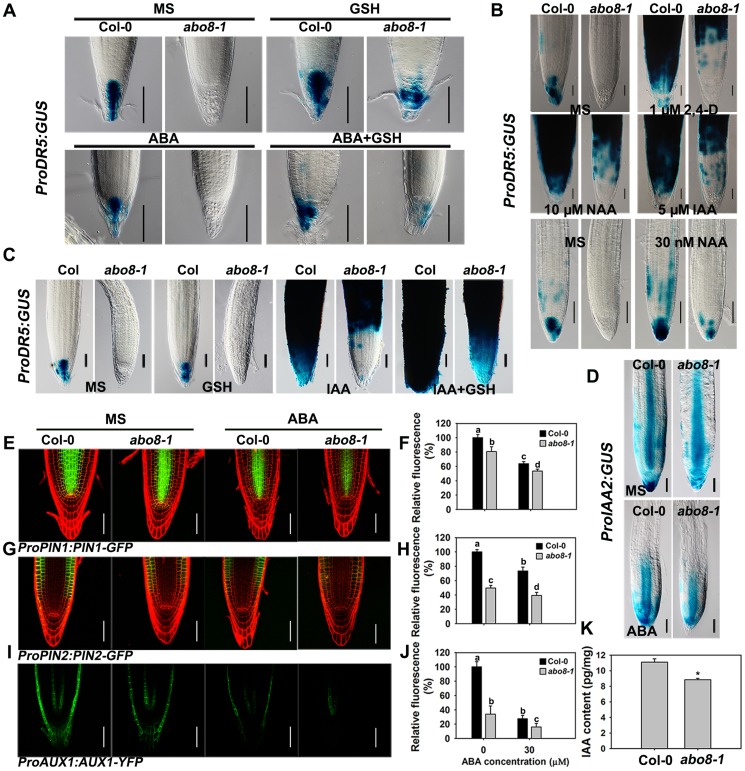
Expression of DR5, IAA2, PIN1, PIN2, and AUX1 is altered in the abo8-1 mutant.A. The expression of ProDR5:GUS in roots of seedlings grown on MS medium or MS medium containing 30 µM ABA, 300 µM GSH, or 30 µM ABA plus 300 µM GSH for 5 days. Bars = 50 µm. B. The expression of ProDR5:GUS in 5-day old seedlings treated in liquid MS medium without or with 1 µM 2,4-D, 5 µM IAA, and 10 µM NAA, or 30 nM NAA for 18 h. Bars = 50 µm. C. The expression of ProDR5:GUS in 5-day old seedlings treated in MS liquid medium without or with 300 µM GSH, 5 µM IAA, or 5 µM IAA plus 300 µM GSH for 18 h. Bars = 50 µm. D. The expression of ProIAA2:GUS with and without ABA treatment. Bars = 50 µm. E. The expression of ProPIN1:PIN1-GFP with and without ABA treatment. Bars = 50 µm. F. The fluorescence of PIN1-GFP in (E). Fluorescence is expressed relative to that of the wild type without ABA. Three experiments were done with similar results, each experiment with three repeats (each repeat with 15 roots). Values are means ±SE from one experiment. Means with different letters are significantly different at P<0.01 for a and b and at P<0.05 for c and d. G. The expression of ProPIN2:PIN2-GFP with and without ABA treatment. Bars = 50 µm. H. The fluorescence of PIN2-GFP in (G). Fluorescence is expressed relative to that of the wild type without ABA. Three experiments were done with similar results, each experiment with three repeats (each repeat with 15 roots). Values are means ±SE from one experiment. Means with different letters are significantly different at P<0.01 except for c and d at P<0.05. I. The expression of ProAUX1:AUX1-YFP with or without ABA treatment. Bars = 50 µm. J. The fluorescence of AUX1-YFP in (I). Fluorescence is expressed relative to that of the wild type without ABA. Three experiments were done with similar results, each experiment with three repeats (each repeat with 15 roots). Values are means ±SE from one experiment. Means with different letters are significantly different at P<0.01 except for b and c at P<0.05. K. The abo8-1 contained less auxin than wild type. 7-day seedlings were used for auxin contents measurement. Each value is the mean ± SD (n = 4). *: P<0.05.